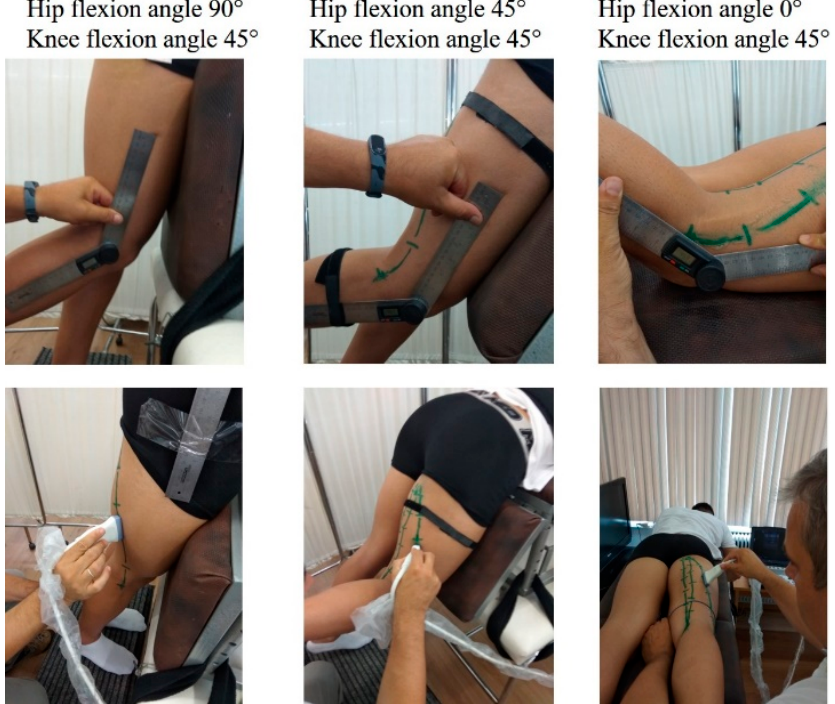
Figure 1. (Upper panel) Illustration of the position of the participant at three characteristic combinations of knee and joint positions. In each position the knee and hip joint angle were measured using an analogue goniometer. (Lower panel) Example of ultrasound scanning along the muscle path in each joint configuration.